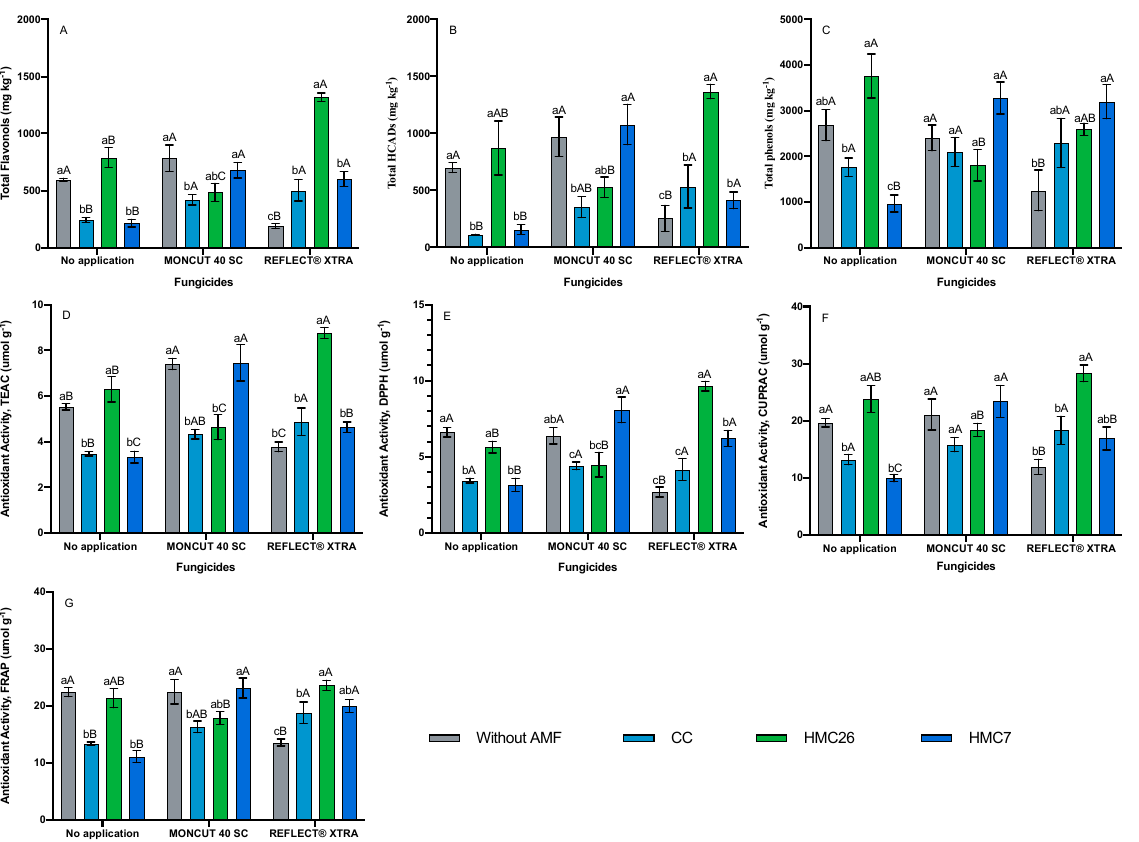
Figure 2. Phenolic compounds and antioxidant activity of Solanum tuberosum leaves, CB2011-104 genotype under inoculation of arbuscular mycorrhizal fungi and fungicide treatments. ( A ) Total flavonols by HPLC-DAD, ( B ) Total hydroxycinnamic acids by HPLC-DAD, ( C ) Total phenols determined by the Folin-Ciocalteu method, ( D ) AA determined by the TEAC (Trolox equivalent antioxidant capacity) method, ( E ) AA determined by the DPPH (2,2-diphenyl-1-picrylhydrazyl) method, ( F ) AA determined by the CUPRAC (copper reducing antioxidant capacity) method and ( G ) AA determined by the FRAP (ferric reducing antioxidant power) assay. Means followed by the same lowercase letter compare inoculation for the same fungicide and uppercase letters compare fungicides within the same inoculation condition (Tukey 5%). Where: without AMF, CC: Claroideoglomus claroideum ; HMC26 : Claroideoglomus lamellosum and HMC7: Funneliformis mosseae . Contrary to the observations for CB2011-104, in the CB2011-509 genotype (Figure 3A,B), similar concentrations of HCADs and flavonols were observed in the treatment with CC and HMC7 combined with the use of the ReflectXtra fungicide (Figure 3A,B). However, there was a trend for increased total HCADs and flavanols in the presence of fungicides in the leaves of inoculated plants, mainly with the use of ReflecXtra. The use of MONCUT showed no significant increases in the concentrations of phenolic compounds in the leaves of AMF-inoculated plants. The CB2011-509 genotype showed the highest concentrations of 5-caffeoylquinic acid, quercetin-3-glucosylrutinoside, quercetin-dihexoside, and quercetin-rutinoside when inoculated with CC and HMC7 when the fungicide ReflecXtra was applied (Figure S2).